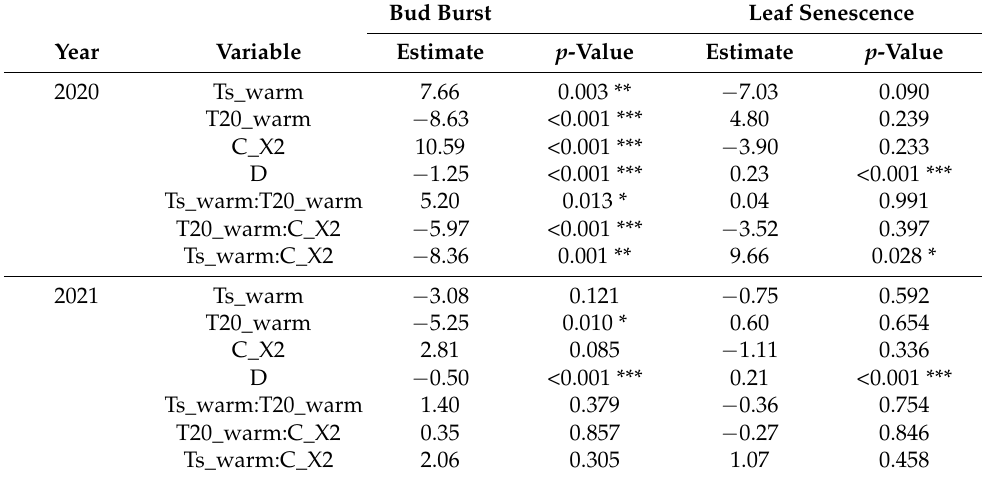
Table 3. Estimates and p -values for the modeled bud burst and leaf senescence in 2020 and 2021. The “cold” condition of the seed maturation temperature is the standard condition to which the “warm” (Ts_warm) conditions are compared. The “cold” temperature treatment of the saplings in 2020 is the standard condition to which the “warm” treatment (T20_warm) is compared. The first cross X1 is the standard to which the second cross (C_X2) is compared. D is the day of observation. Bud Burst Leaf Senescence Year Variable Estimate p -Value Estimate p -Value 2020 Ts_warm 7.66 0.003 ** − 7.03 0.090 T20_warm − 8.63 <0.001